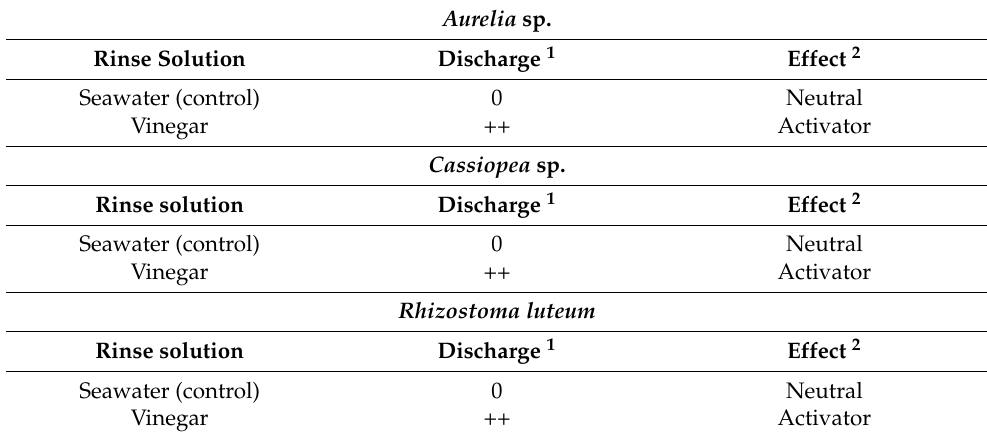
Table 2. Nematocyst response in scyphozoan jellyfish after the application of seawater (control) and vinegar. The number of replicates was ten for each rinse solution in Aurelia sp. and Cassiopea sp., and three in Rhizostoma luteum